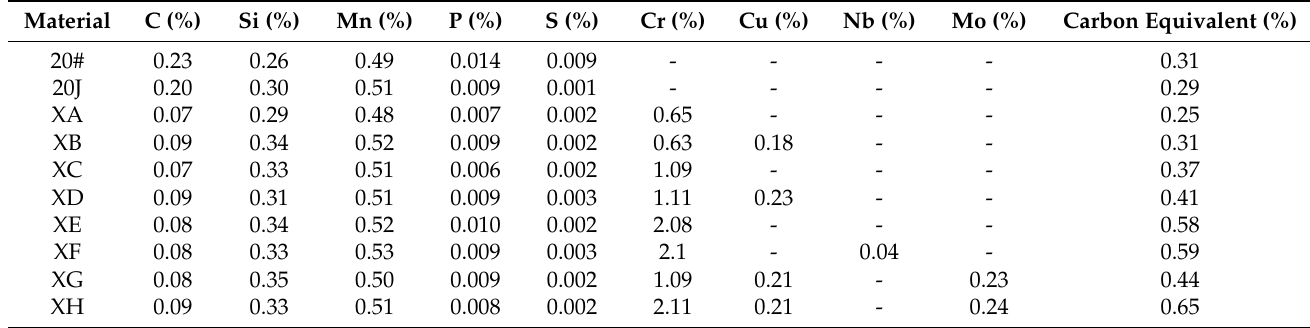
Table 10. Compositions of 20# steel and optimized steel.